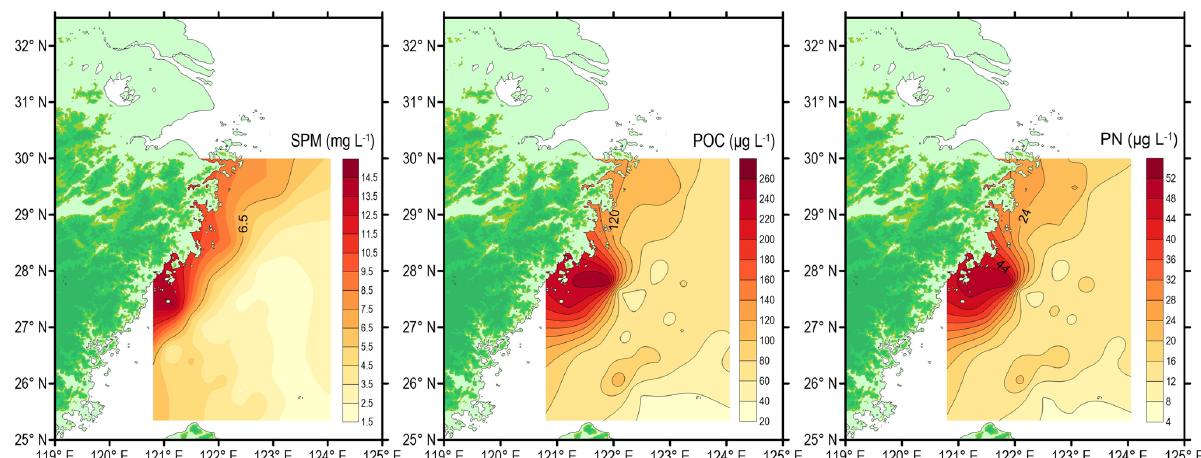
Figure 4. Spatial distributions of suspended particulate matter (SPM, mgL − 1 ) , particulate organic carbon (POC, µgL − 1 ) and particulate nitrogen (PN, µgL − 1 ) around the deep chlorophyll maximum layer in the southern East China Sea during summer 2013.